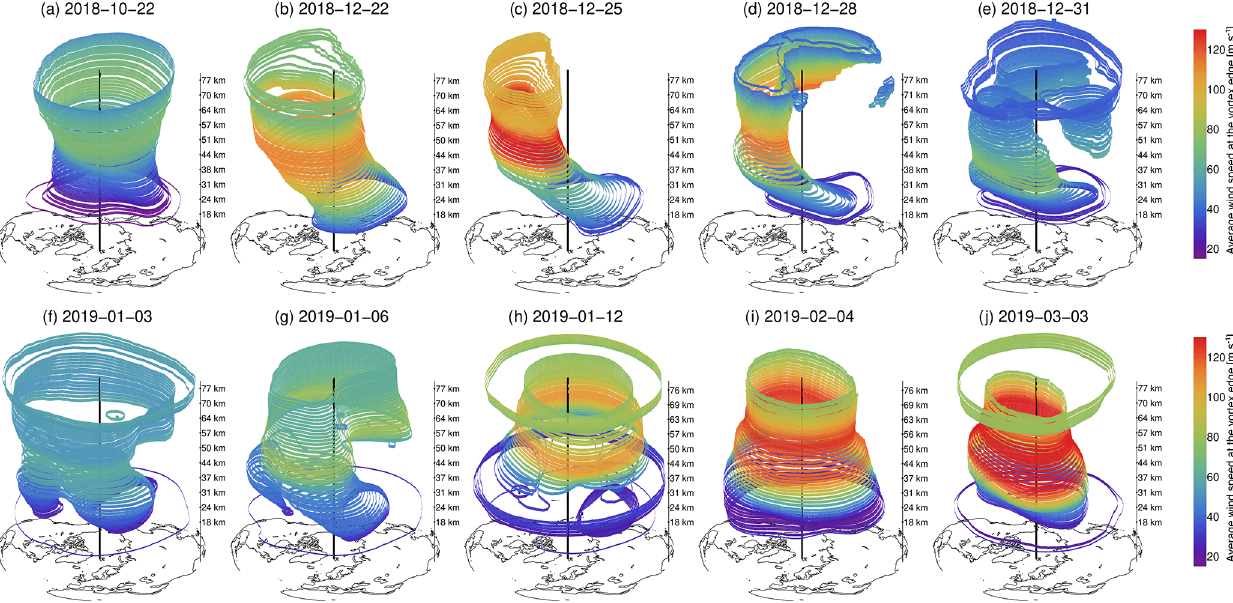
Figure 6. Contours of the polar vortex during winter 2018/2019. The central date of the SSW is 2 January 2019. The vertical black line is positioned at Ny-Ålesund.